Question: Is the quantity shown trending increasing or decreasing?
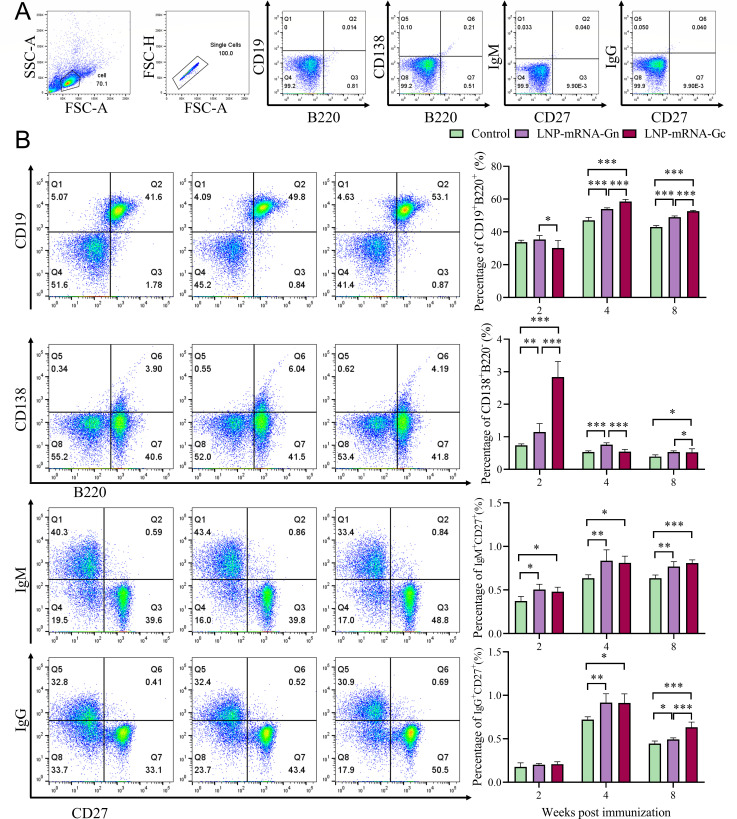
Answer: increasing